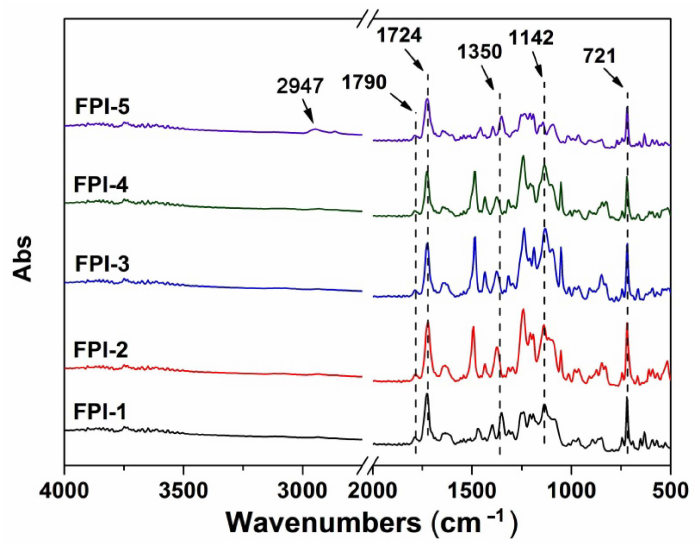
Figure 5. FTIR spectra of the FPI